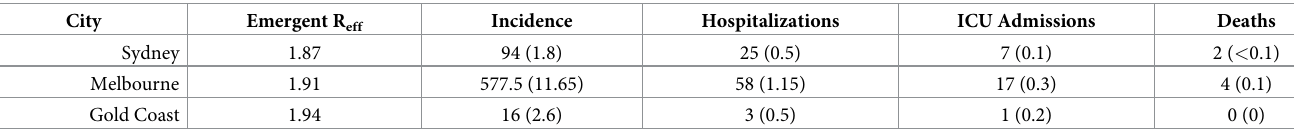
Table 5. Summary counts (and per 100,000 population estimate) of each simulation.